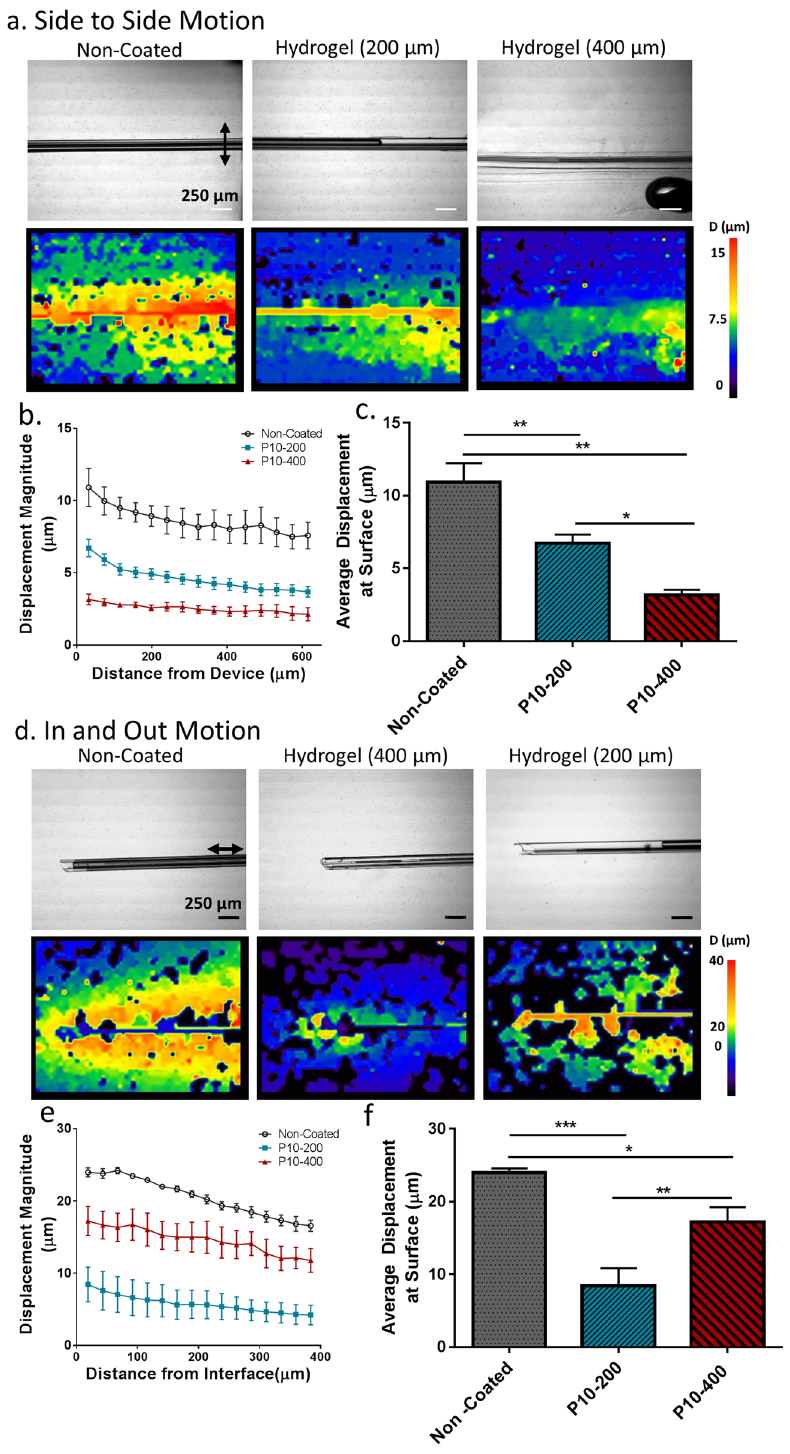
Figure 2. Hydrogel In Vitro Characterization. Hydrogel coated devices reduce local strain fields which result from micromotion compared to non-coated controls. Particle image velocimetry was used to quantify the displacement surrounding the device. ( a ) Bright field images and strain field plot overlays following a 30 micron displacement which was applied to devices perpendicular to the device axis embedded within an agarose tissue phantom to mimic micromotion from rotational accelerations. (scale bar 250 μ m). ( b ) Average line profiles of the displacement magnitude as a function of distance from the device and ( c ) the average displacement at the surface were calculated. Hydrogel coated samples significantly reduced strain fields around the device. Thicker hydrogel coatings (P10–400) had greater strain reduction compared to thinner hydrogel coatings (P10–200). Sample sizes: non-coated n = 3, P10–400 hydrogel: n = 3, P10–200 μ m hydrogel: n = 5. ( d – f ) Strain field maps, line profiles, and surface displacement for non-coated and hydrogel coated samples following a 30 μ